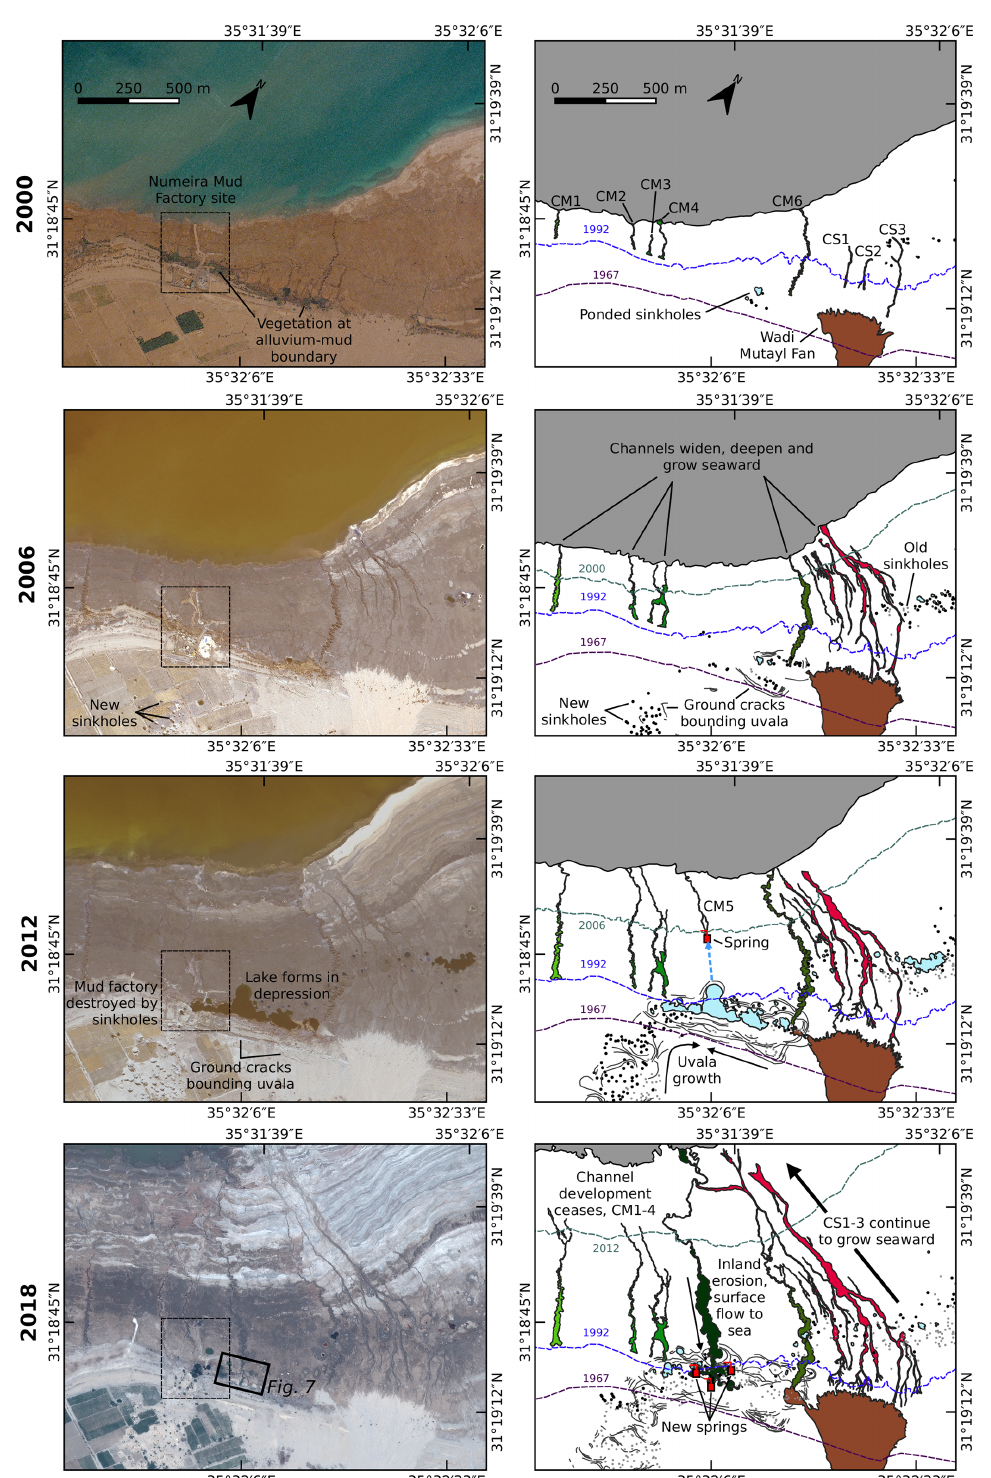
Figure 6. Evolution of stream channels and karstic depressions from 2000 to 2017. Left column shows aerial or satellite imagery. The image sources are aerial survey of the RJGC (2000); Quickbird satellite (2006, 2012) and Pleiades satellite (2018). Right column shows maps of channels (red: straight/braided, green: meandering), ground cracks denoting the limits of a large-scale depression, and depression or sinkhole-hosted ponds (blue). Flow has converged upon CM5 in the years following 2012, with the other channels ceasing to prograde